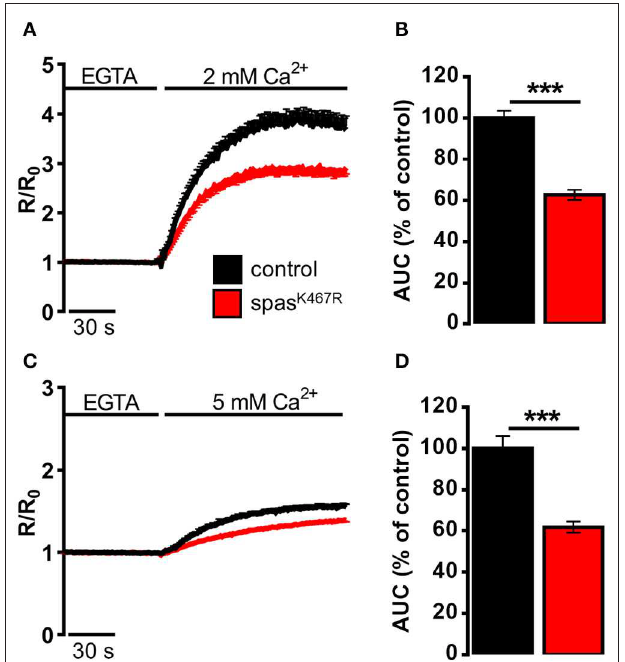
FIGURE 2 | Ca 2 + dynamics induced by (A,B) SOCE activation, (C,D) SOCE activation in K + -based medium (see Materials and Methods) in neurons dissociated from larval brains expressing spastin K467R , and relative controls, as detected by fura-2. (A,C) Cells were pre-treated with thapsigargin in a Ca 2 + -free medium for 8min, to empty intracellular stores, and then (A) 2mM or (C) 5mM CaCl 2 was added. In all panels, average traces are represented as R/R 0 values of n > 100 cells. (B,D) Histograms report the average area under curve (AUC) values of the traces recorded. Data are presented as mean ± SEM of n > 100 cells. *** p < 0.001.